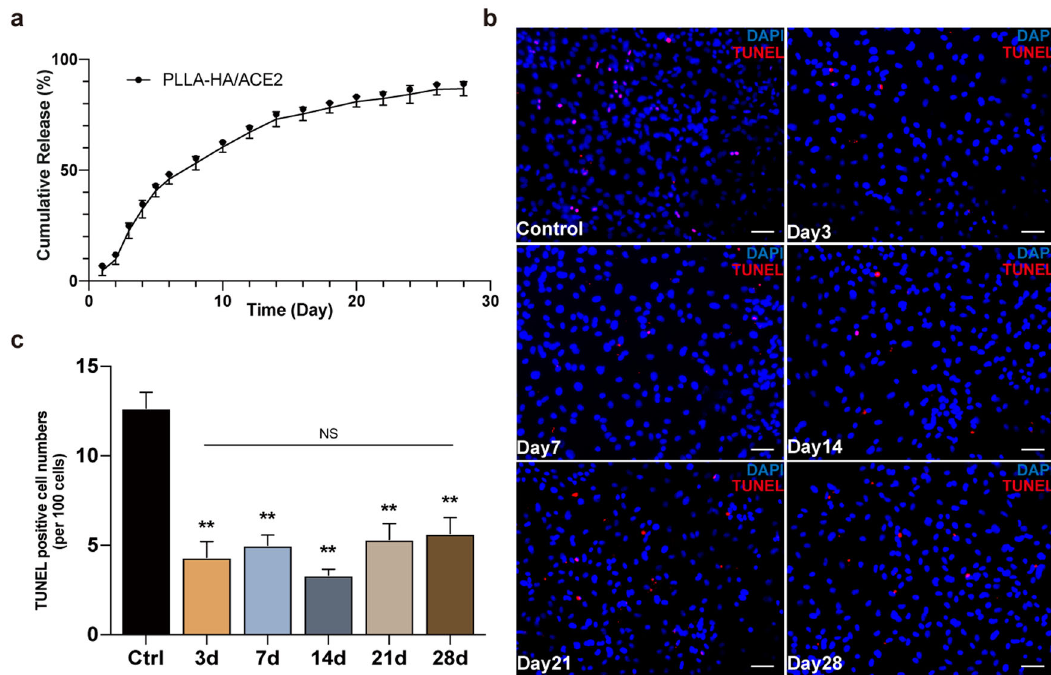
Fig. 5 rhACE2 patch sustained-release activity test. a In vitro releasing curve of PLLA-HA/ACE2 fi brous membranes. b Releasing buffer collected at speci fi ed time points during release study was added into culture media of NRCMs undergone 6 h hypoxia. Representative immuno fl uorescence image of TUNEL (red) and nuclear visualized by DAPI (blue). Scale bars represented 50 μ m. c Statistical analysis of TUNEL- positive cell counts. n = 3/group. Data were represented as the mean ± SEM and analyzed for statistical signi fi cance using One-way ANOVA followed by Tukey ’ s multiple comparison test; NS no signi fi cant difference; ** P < 0.01 compared to the control